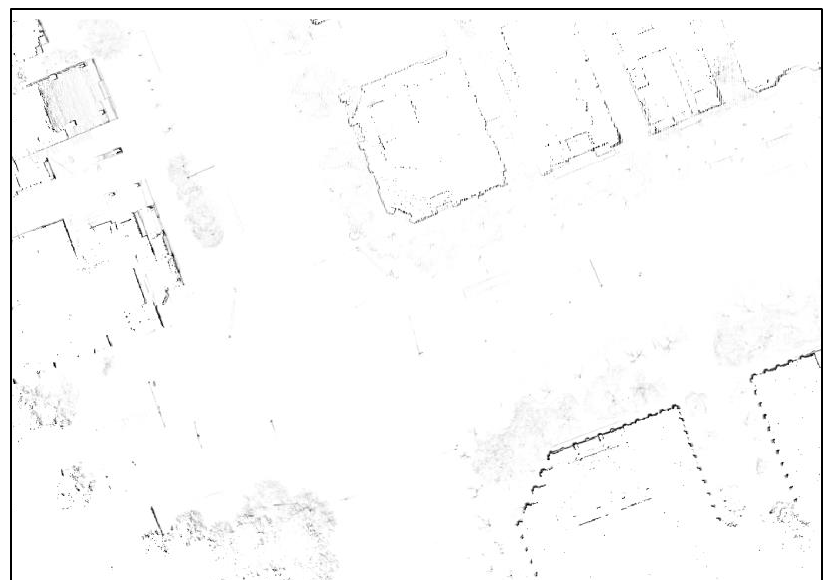
Figure 10. Generated 2D probabilistic occupancy grid map.